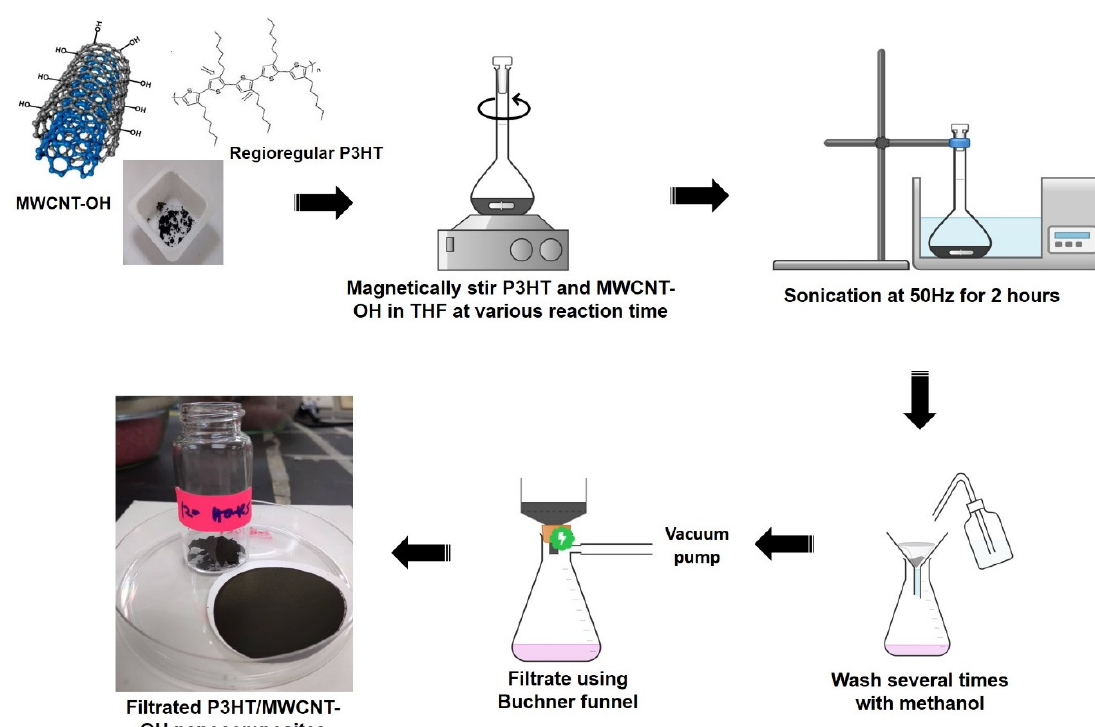
Figure 1. Schematic procedure for preparation of P3HT-wrapped MWCNT-OH nanocomposites.